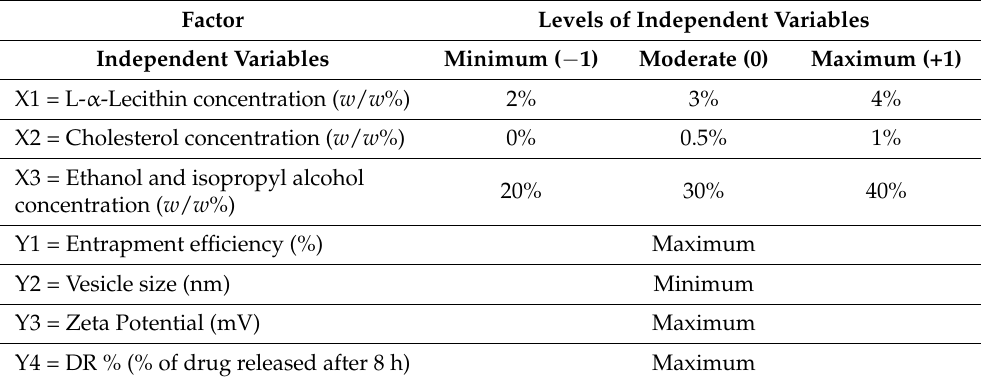
Table 3. Evaluation of the independent variables in the Box–Behnken design. Factor Levels of Independent Variables Independent